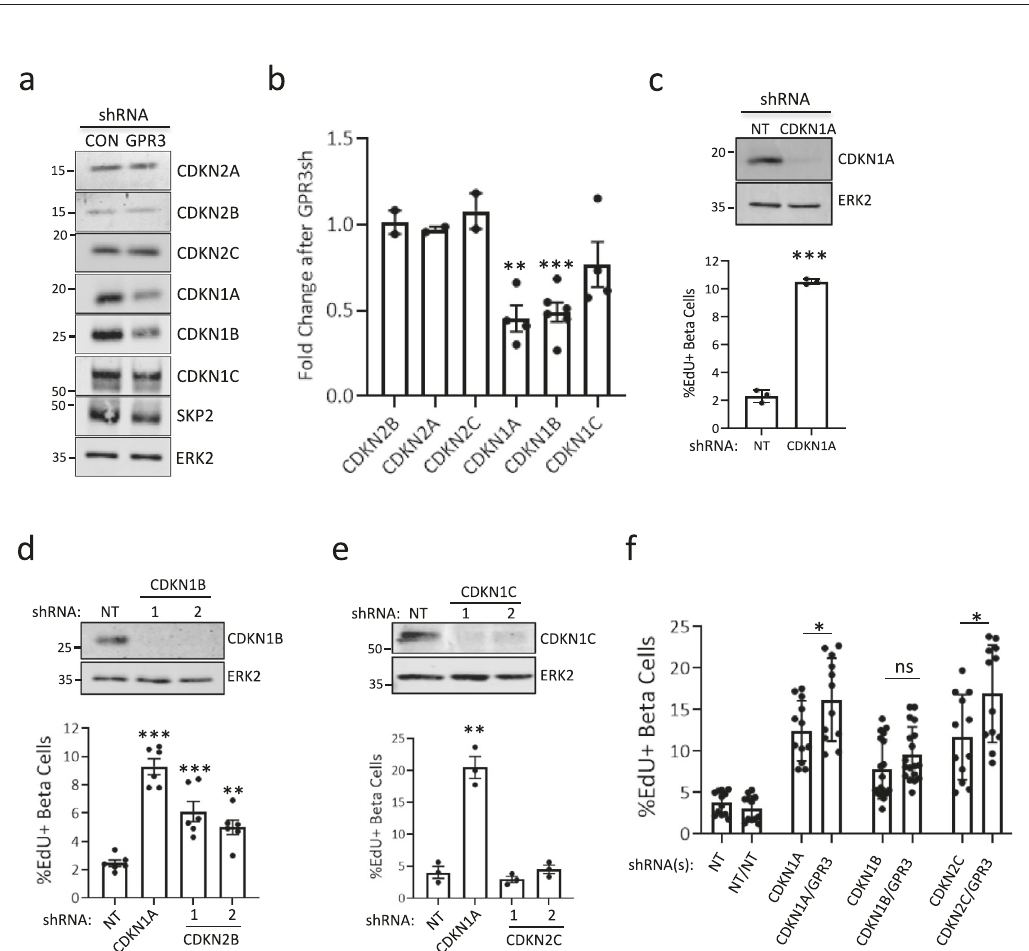
Fig. 2 GPCRome screen identi fi es GPR3 as a regulator of human β cell proliferation. a Z-score plot of screen results. Control cells infected with non- targeting virus (black circles, NT), positive control CDKN2C or CDKN1A shRNA virus (gray circles), or GPCRome library shRNAs (red circles) are shown. The x -axis represents Z-scores of double-positive (EdU, insulin) cells based on the absolute number; the y -axis represents Z-scores for the percentage of total b cells. Dotted blue lines mark the threshold of Z-scores = 2. b Validation data for candidates identi fi ed in the screen. Percentage proliferation achieved for individual shRNAs against indicated targets was averaged over three screens ( n = 3 technical replicates/donor) using islets from three independent donors. c Screen images showing representative NT control or GPR3 shRNA-infected b cells (C-peptide, blue) stained for EdU (red). d Violin frequency distribution plots showing the percentage of EdU + insulin + cells following GPR3 silencing in 18 donors over a 10-day assay period compared to non-targeting control (NT) and CDKN2C and CDKN1A positive controls. Dark line = median, light line = quartiles. e Barplot showing the percentage of EdU + β cells following silencing GPR3 in the presence of the shRNA-resistant GPR3 cDNA tagged with V5 (GPR3-RES-V5) or with NT shRNA control. Western blots showing expression of exogenous GPR3 are shown underneath. f Barplot showing the percentage of EdU + β cells following silencing of GPR3 and fi ve independent shRNAs targeting GPR6 and four independent shRNAs targeting GPR12, the most closely related GPCRs to GPR3. g GSIS in cells silenced for GPR3 compared to NT control. LG low glucose, HG high glucose, KCl depolarizing stimulus. p -values for GPR3 HG = 0.002; GPR3 KCl = 0.005. n = 6 technical replicates. h Insulin content in cells silenced for GPR3 compared to NT control. n = 6 technical replicates. i Dotplot showing C-peptide intensity in EdU + and EdU − populations in cultures silenced for indicated targets. Non-targeting (NT) control shown. n = 200 β cells per condition. All cultures were infected with TAg. p -values: NT = 0.0012; CDKN2C = 1.4 × 10 − 14 ; CDKN1A = 5.0 × 10 − 6 ; GPR3 = 3.4 × 10 − 12 . All plots are representative of three biological replicates. Error bars are de fi ned as the standard error of the mean for n = 3 technical replicates unless stated otherwise. MWs for Western blot markers are in kDa.